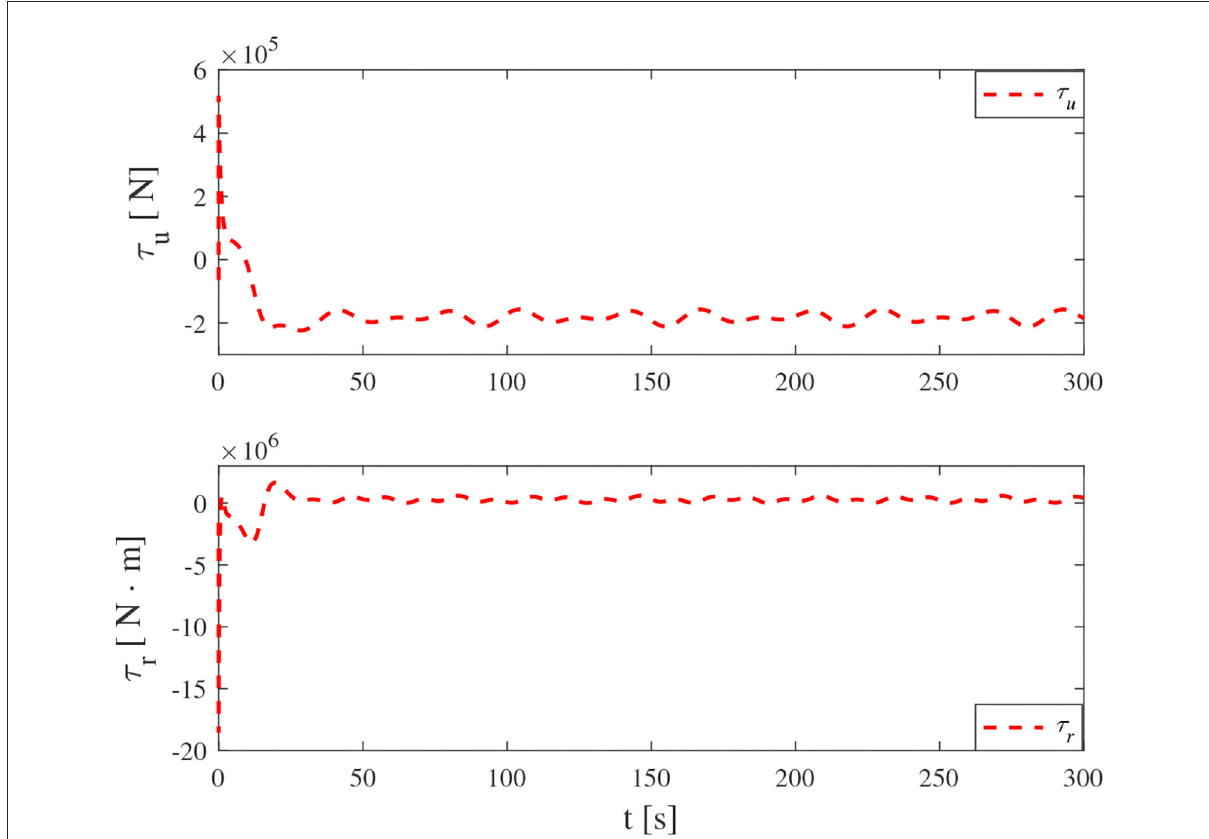
FIGURE12 Control input τ u and τ r in Case